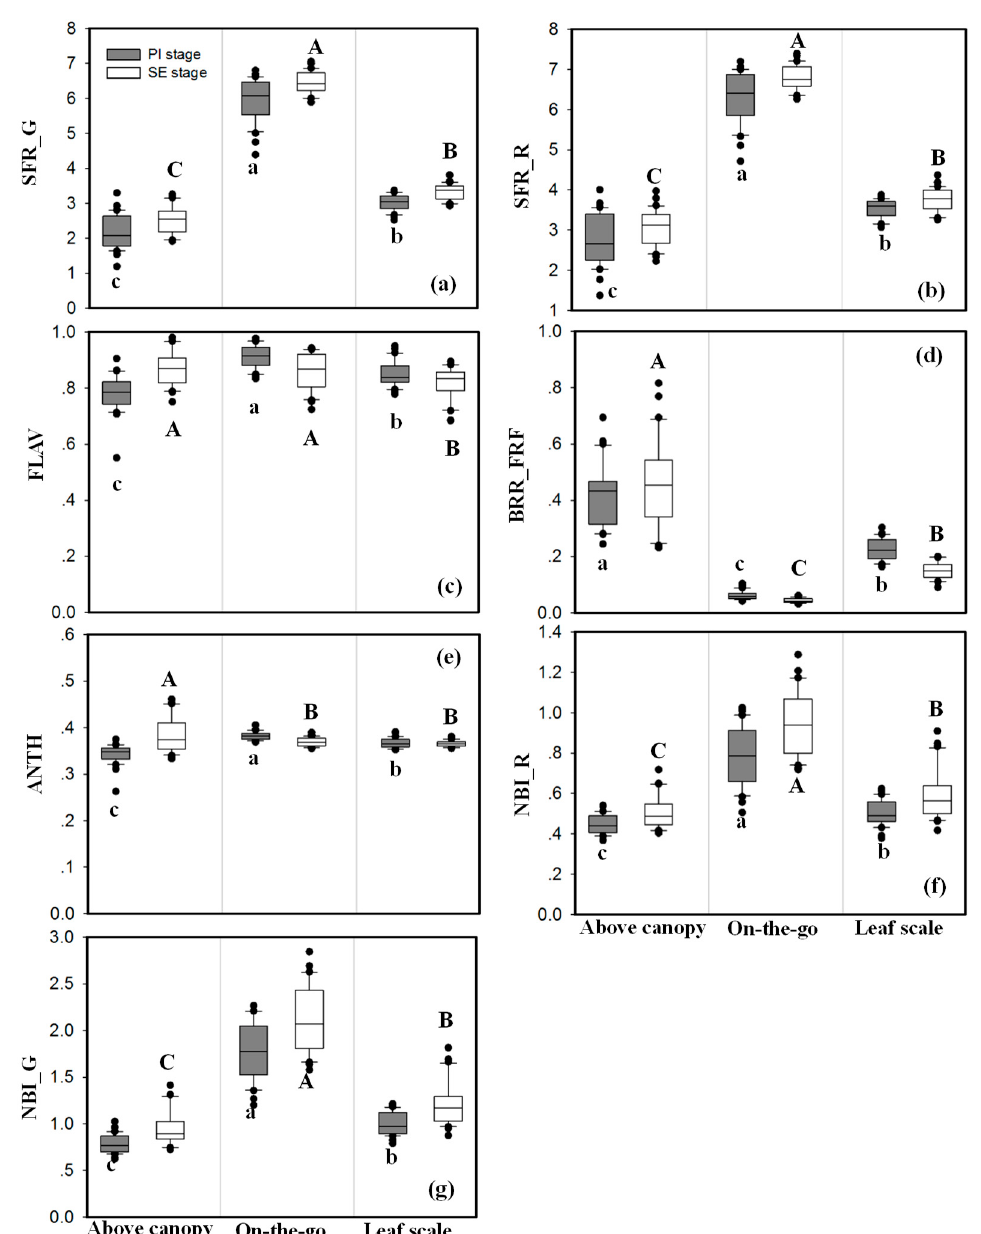
Figure 1. Box plots of selected Multiplex index values for the above canopy, on-the-go, and leaf scale measuring modes at the panicle initiation and stem elongation stages in 2013: Simple fluorescence ratio under green excitation (SFR_G) ( a ), simple fluorescence ratio under red excitation (SFR_R) ( b ), flavonol (FLAV) ( c ), blue–green to far-red fluorescence ratio (BRR_FRF) ( d ), anthocyanins (ANTH) ( e ), nitrogen balance index under UV and red excitation (NBI_R) ( f ), and nitrogen balance index under UV and green excitation (NBI_G) ( g ). Within the same growth stage, different lowercase (panicle initiation stage) or uppercase letters (stem elongation stage) above or below the boxes indicate that the Multiplex index values differed significantly according to the least significant difference test at P ≤ 0.05.